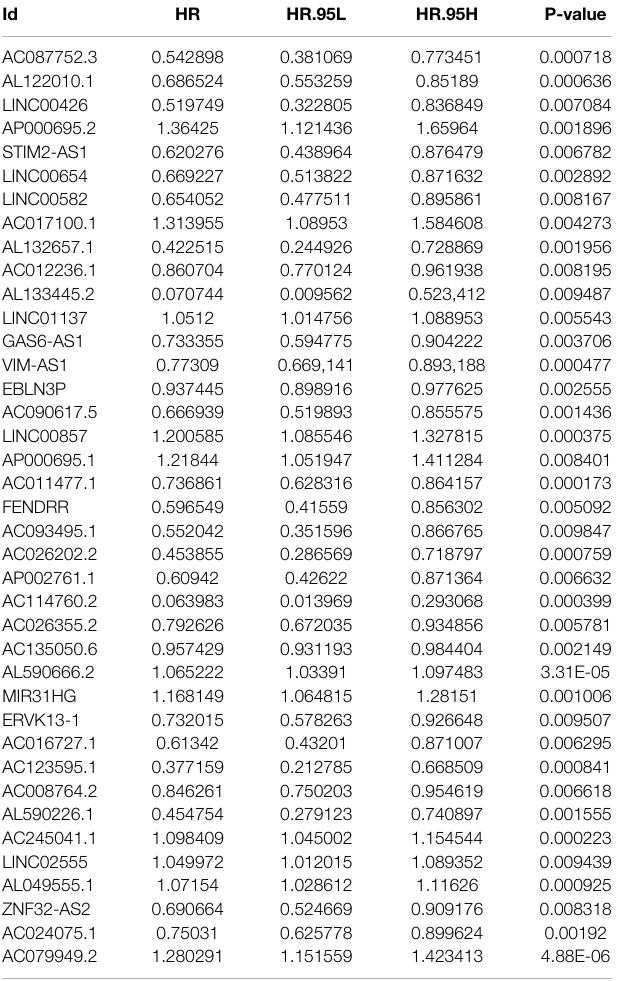
TABLE 5 | Univariate Cox regression analysis of training TCGA sets of prognostic m 6 A-related lncRNAs in LUAD.